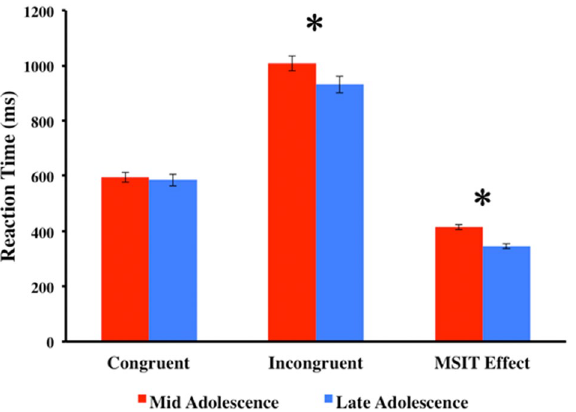
Figure 5. Differences in Reaction Time (ms) between congruent and incongruent trials across mid-adolescence and late-adolescence. MSIT behavioural effect was calculated by subtracting reaction time of congruent trials from reaction time of incongruent trials of each time point (*p < .001). Bars represent 95% CI. See Table 3 for more information.